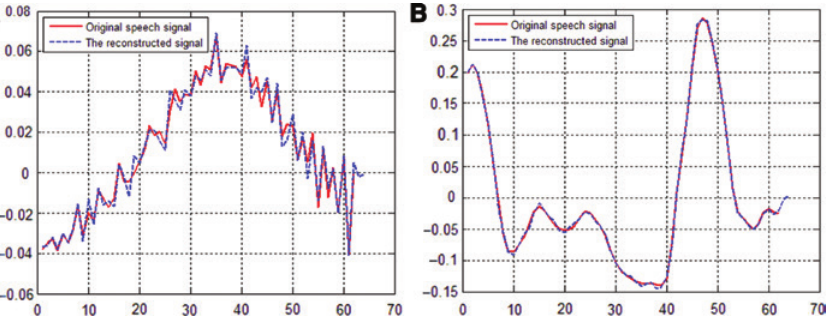
for Two Different Energy Level Frames. 90